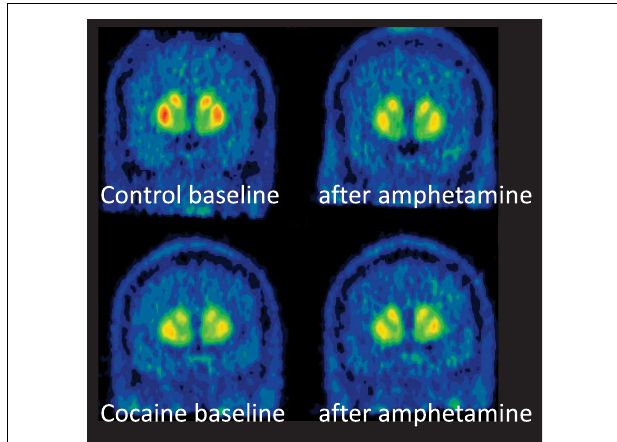
FIGURE 1 | PET scans in a healthy control and cocaine-dependent subject .The comparison of the top panels (pre- and post-amphetamine administration) in the healthy control shows that radiotracer ([11C]raclopride) binding is reduced in the striatum following amphetamine. The cocaine-dependent subject (bottom panel) has have lower D2 receptors compared the control in the baseline condition. In addition, the cocaine abuses has less radiotracer displacement ( ∆ BPND) following amphetamine. Adapted fromTrifilieff and Martinez “Cocaine: Mechanism and Effects in the Brain” in “The Effects of Drug Abuse on the Human Nervous System” M. Kuhar and B. Madras editors, 2012, publisher Neuroscience-Net,